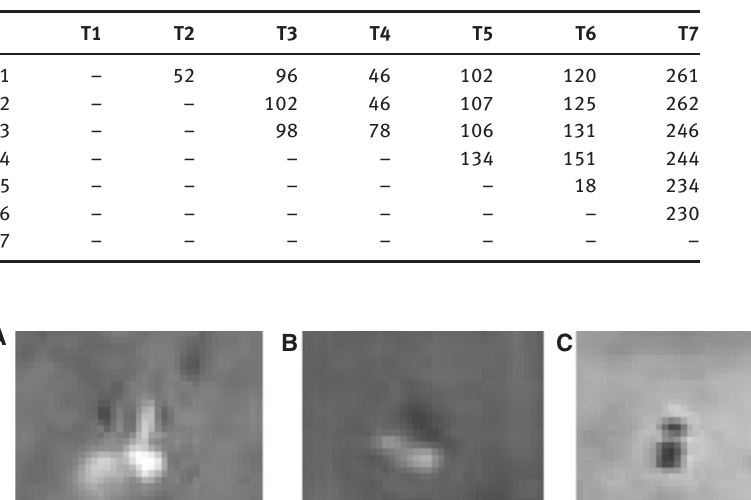
Table 1: Distance Between All Six Tanks and One Diesel Electric Generator.